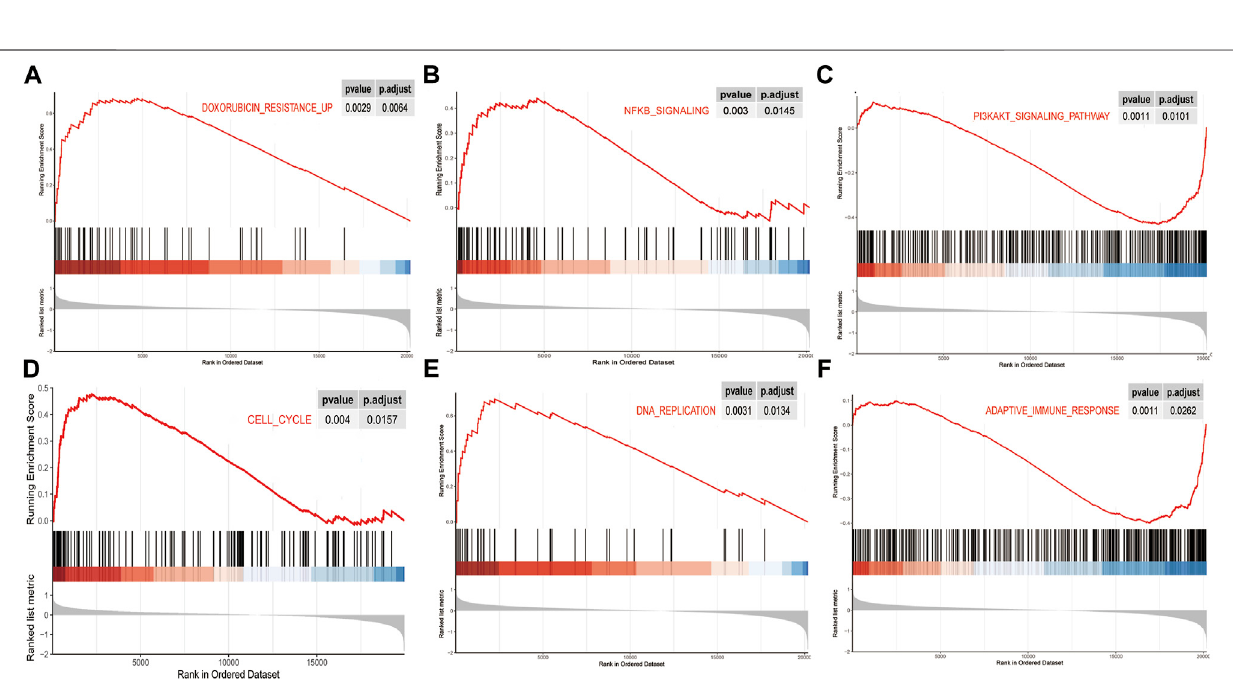
Frontiers in Genetics |